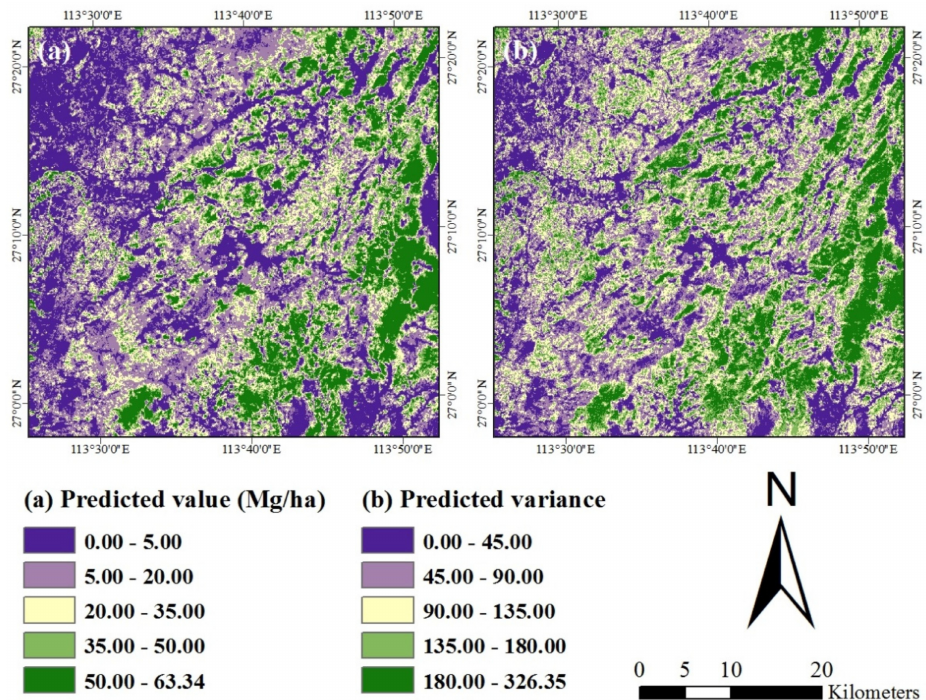
Figure 7. The maps of ( a ) forest carbon density and ( b ) its variances predicted by support vector regression (SVR) using the sample plot data combined with the LPE-SEC corrected